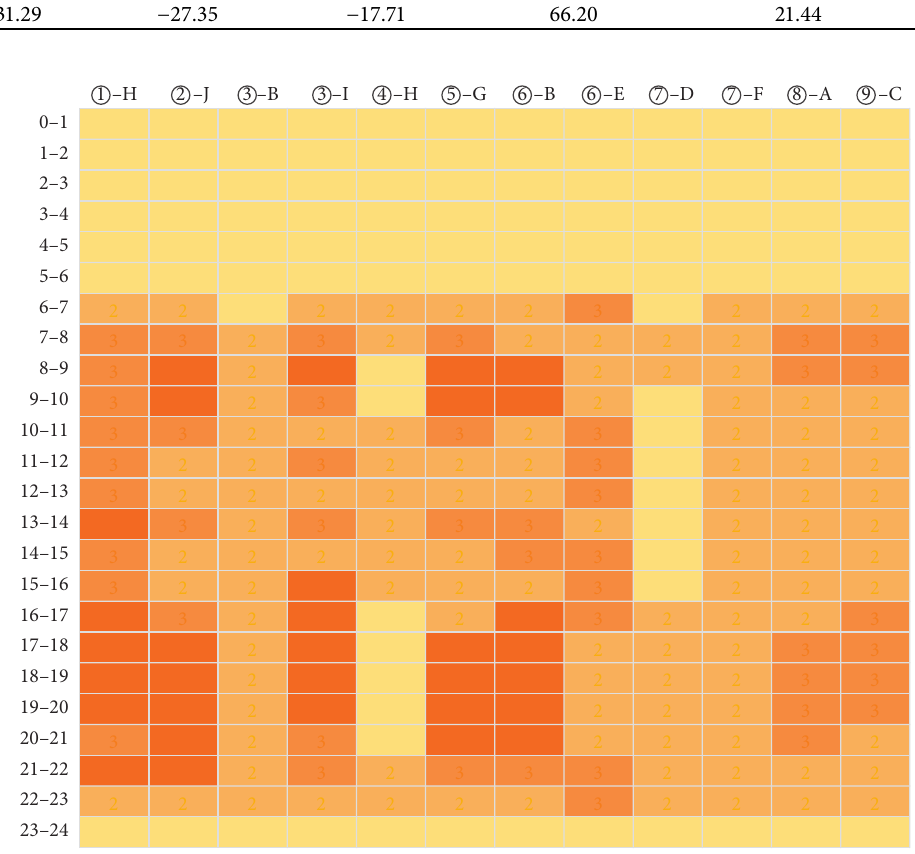
Figure 4: The color chart of truck path lengths at different time